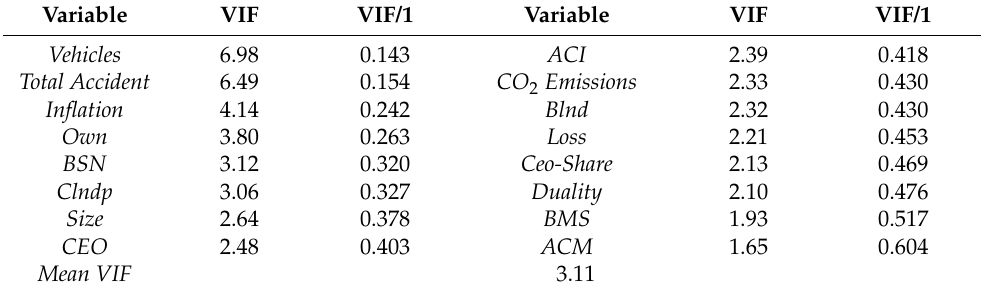
Table 9. VIF collinearity test of three main